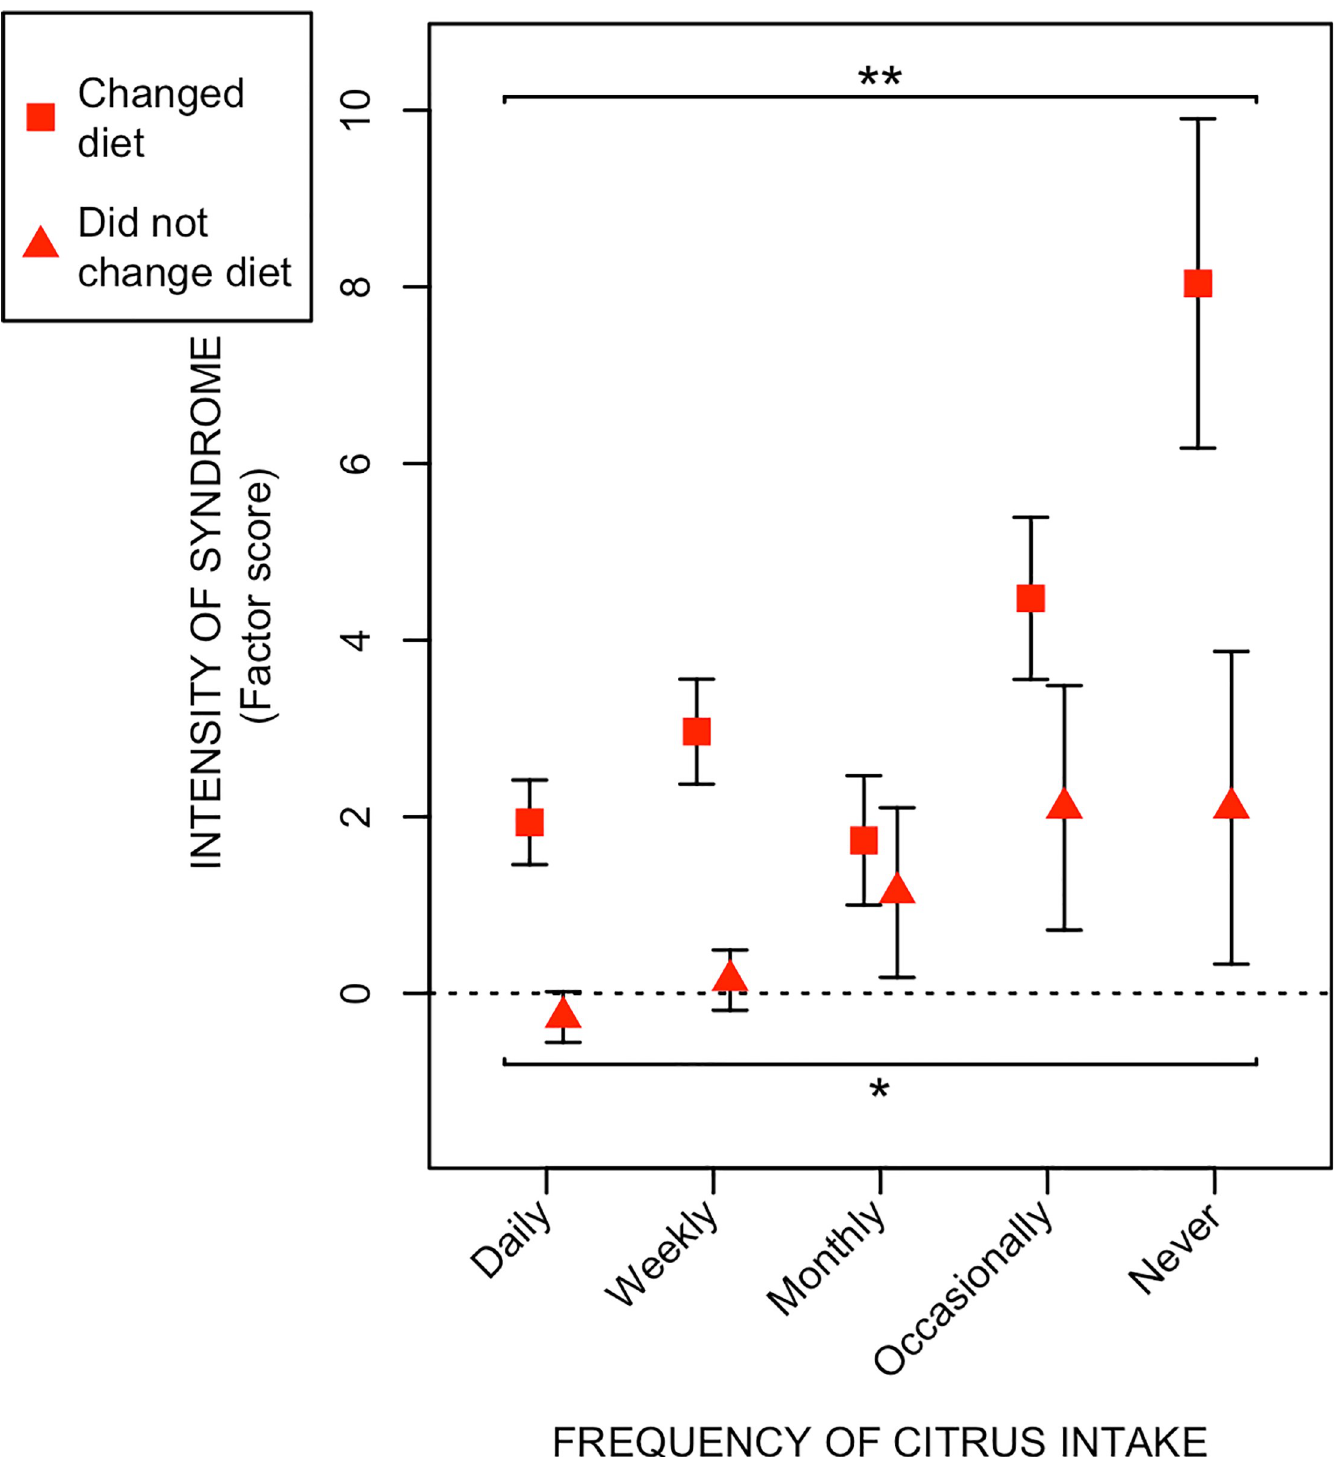
Fig 4. Relationship between radiation-induced defecation-urgency syndrome and frequency of citrus fruit intake, stratified by those who have changed and those who have not changed dietary behavior after radiotherapy. The figure depicts the relationship between frequency of citrus fruit intake (x-axis) and the intensity (factor scores) the defecation-urgency syndrome (y-axis) among long-term gynecological cancer survivors stratified according to having or not having made dietary changes after receiving radiotherapy (see the Methods section for detailed information). Red squares and green triangles denote the mean intensities of the syndromes within certain citrus intake frequency levels. Vertical black lines stretch between plus-minus the standard error of the mean. Asterisks correspond to significance levels of the Spearman correlations between syndrome intensity and frequency of citrus intake according to: p � 0.001 - ��� , 0.001 < p � 0.01 - �� . 0.01 < p � 0.05 - � . https://doi.org/10.1371/journal.pone.0208115.g004 PLOS ONE | https://doi.org/10.1371/journal.pone.0208115 January 2,